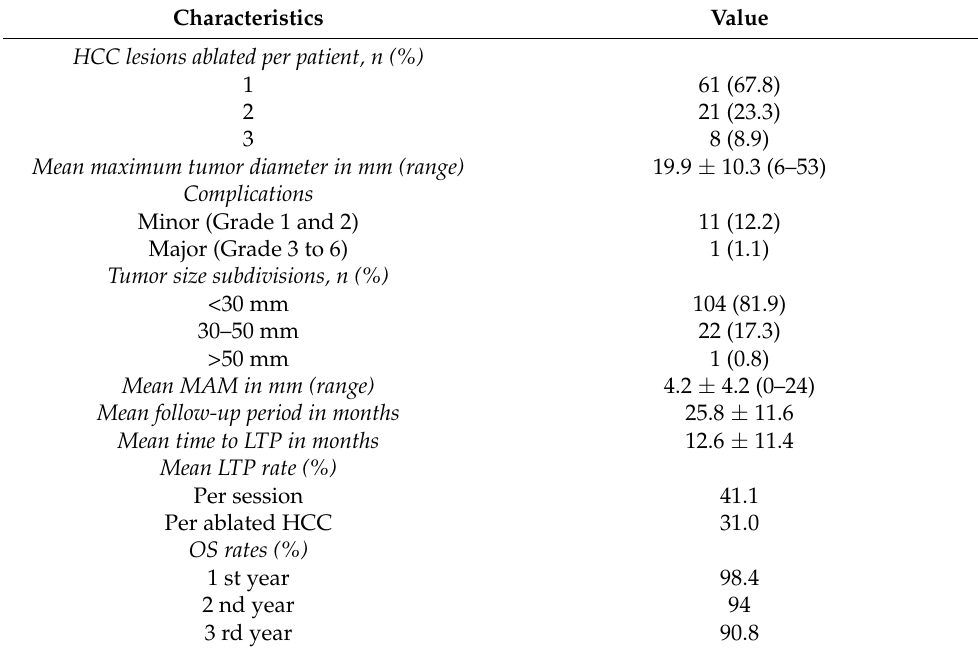
Table 2. Characteristics of 127 HCC lesions ablated with stereotactic MWA in 88 patients and 90 sessions.